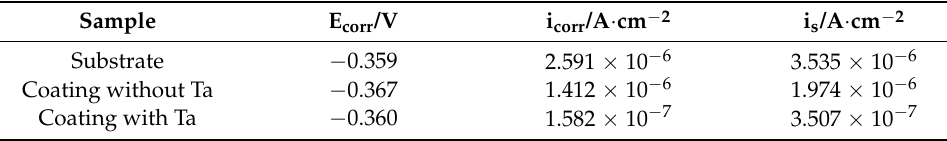
Table 3. Electrochemical parameters obtained from Figure